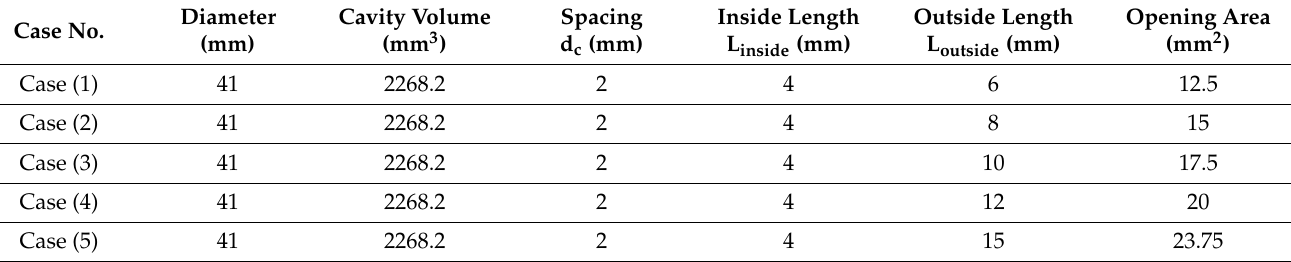
Table 1. Specifications of closed PA